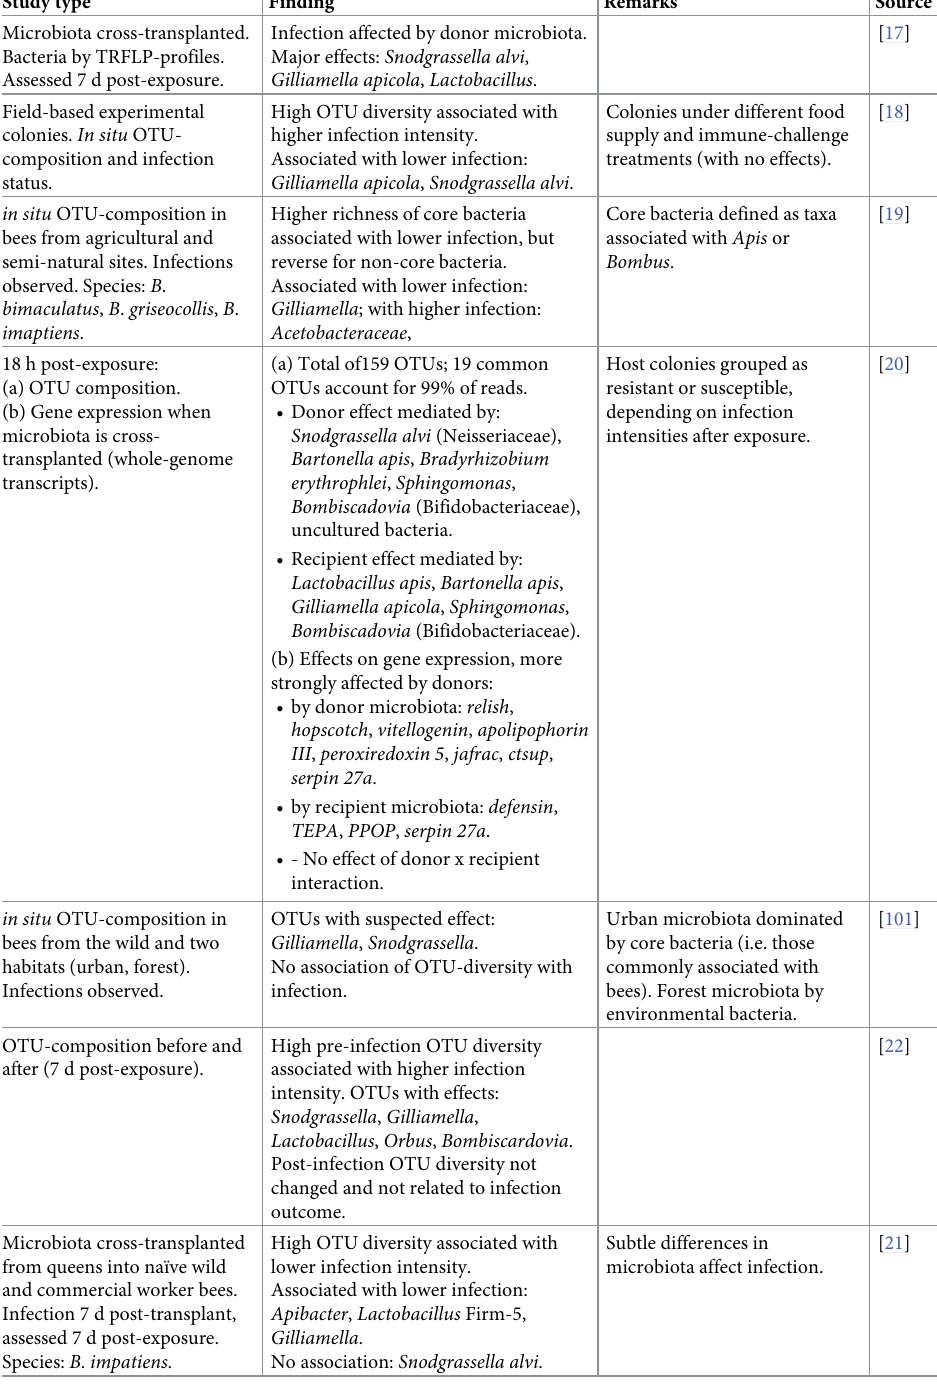
Table 7. Studies on the protective effects of microbiota against Crithidia infections in bumble